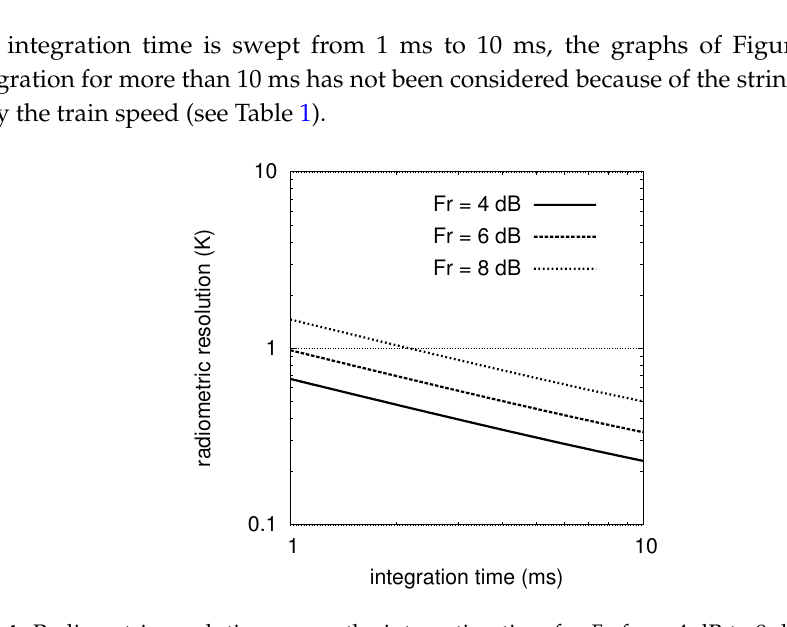
Figure 4. Radiometric resolution versus the integration time for F R from 4 dB to 8 dB. These noise figures are feasible at mm-waves with the present